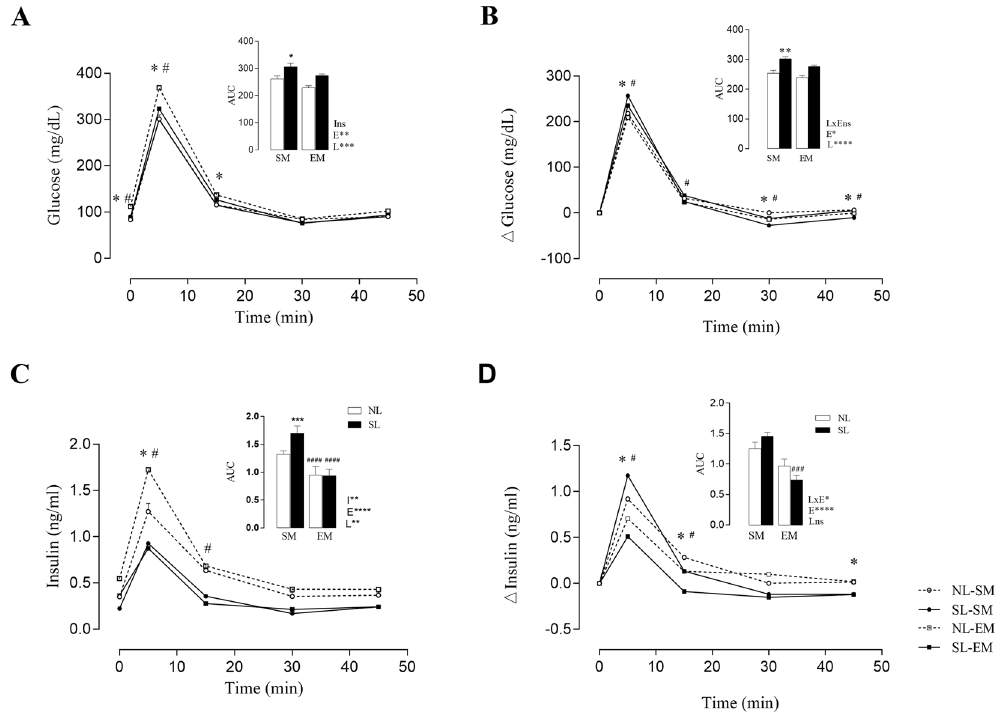
Figure 4. Effect of low intensity physical exercise training in adult offspring plasma glucose and insulin levels during the ivGTT. The upper panel represents the area under the curve (AUC). ( a ) plasma glucose, ( b ) plasma insulin, ( c ) increments ( Δ ) of plasma glucose and ( d ) increments ( Δ ) of plasma insulin. LxE, interaction between the exercise factor and the litter factor; E, exercise factor and L, litter factor; * p < 0.05 ** p < 0.005 and *** p < 0.001, **** p < 0.0001 by two-way ANOVA and Tukey’s test. (n = 6–18). The # or * represents p < 0.05 in each time points of the bw curve, was calculated by repeated measures ANOVA. Over the lines and bars, ( * ) represents NL-SM compared with SL-SM and ( # ) represents SL-SM compared to